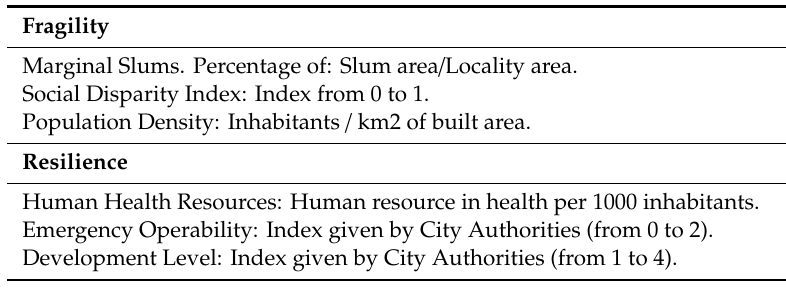
Table 2. Rules defined for the FIS sub-model used to estimate Life Lines Sources Damage (LLSD). Table 3. Indicators used for the Aggravation Fuzzy